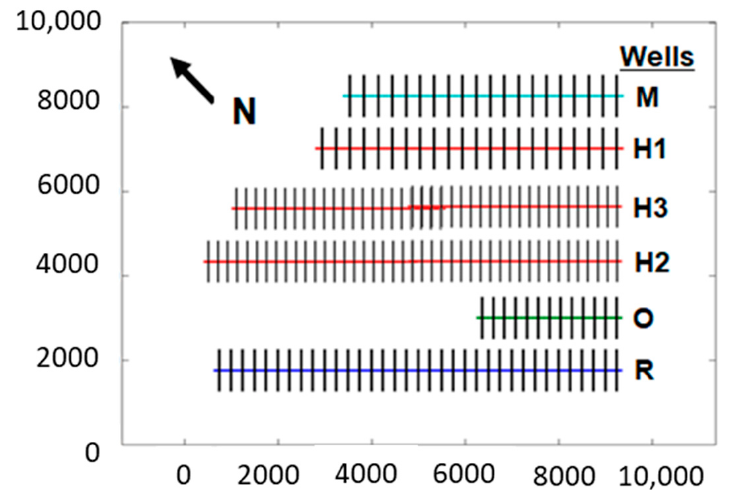
Figure 2. Map view of the base case (H1) and neighboring wells in the study area. The well is located in the lower Eagle Ford above the top Buda limestone [25].